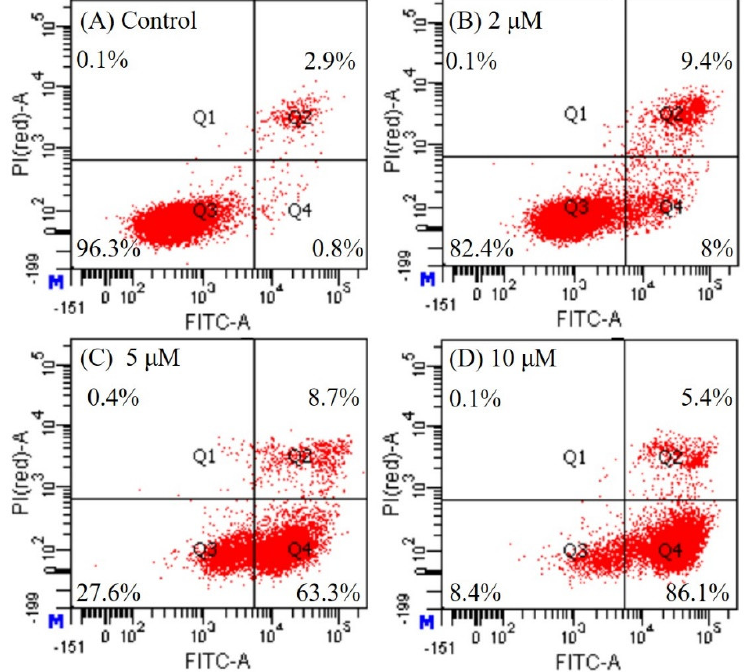
Figure 6. Morphological detection of apoptosis using 4′,6-diamidino-2-phenylindole (DAPI) staining (100×) on A549 cells treated with compound 9 : ( A ) control group; ( B ) 2 µM; ( C ) 4 µM; ( D ) 6 µM. Detection of Apoptosis Using Annexin V Fluorescein Isothiocyanate (FITC)/Propidium Iodide (PI) Staining